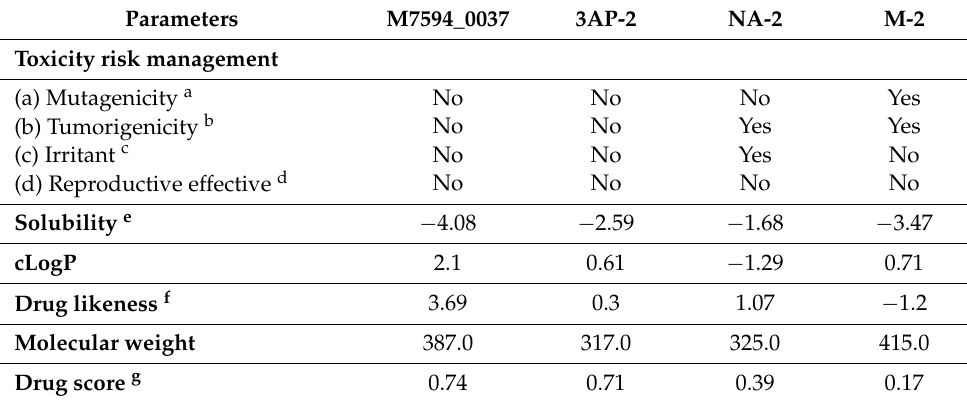
Table 2. In silico pharmacokinetic and toxicity prediction of M7594_0037 and its derivatives.